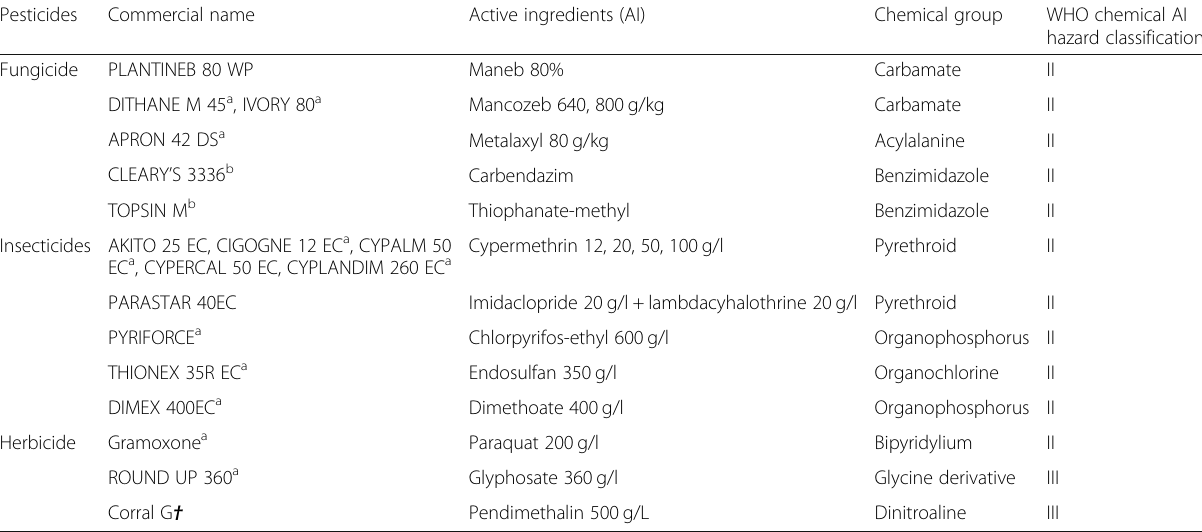
Table 2 The major pesticides used by tomato farmers in the west region of Cameroon, 2017 Pesticides